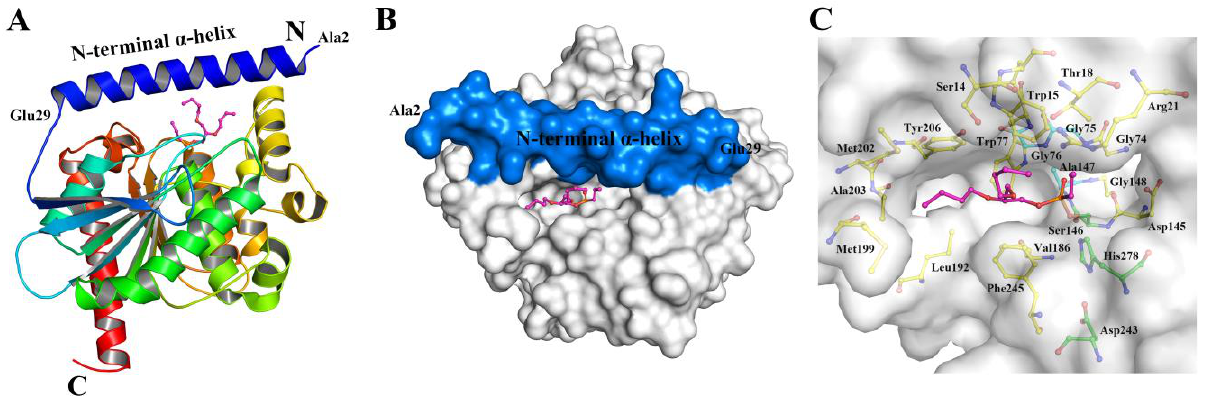
Figure 2. Location of N-terminal extensional long α -helix of arylesterase LggEst shown in cartoon ( A ) and surface ( B ), and the substrate binding cleft of LggEst ( C ). N-terminal extensional α -helix (Ala2-Glu29) is shown in blue. The ligand (2 R )-2,3-dibutoxypropyl hydrogen ( S )-propylphosphonate (HY4) is shown in pink ball and sticks. The catalytic triad are shown in green ball and sticks. The residues serving as the oxyanion hole are shown in cyan ball and sticks. These structural images of LggEst are generated using the software PyMOL based on 3D structure (PDB id: 4PO3) of the homologue esterase B from L. rhamnosus HN001.